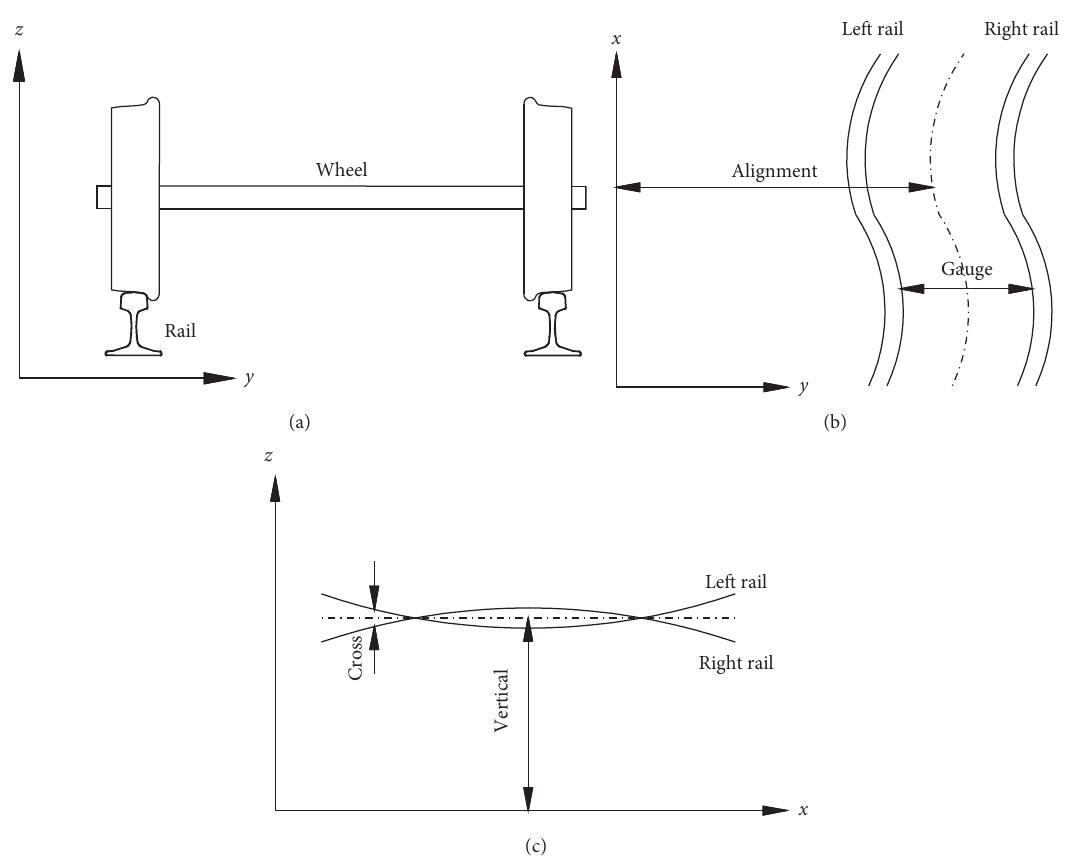
Figure 1: Schematic diagram of wheel-rail contact and rail irregularity types. (a) Wheel-rail contact. (b) Alignment and gauge irregularities. (c) Vertical and cross irregularities.